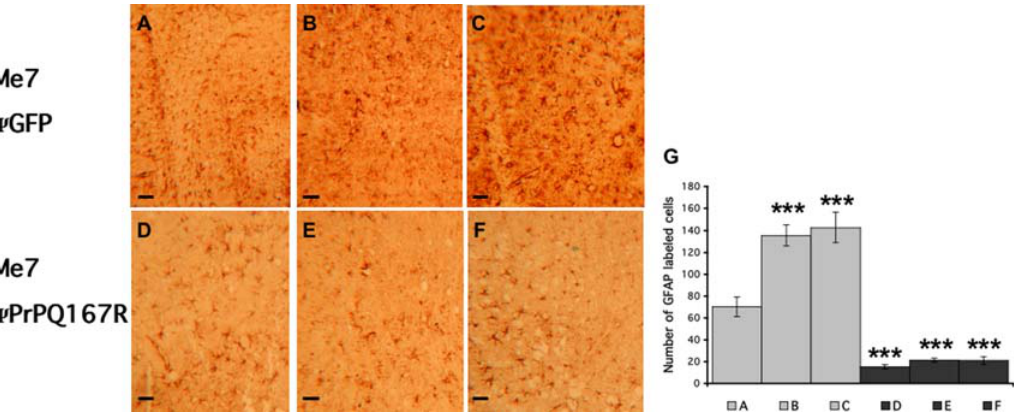
Figure 8. GFAP labelling in tissue sections of prion-infected mice treated with Y GFP or Y PrPQ167R. The plus ( + ) signs indicate that the mice were inoculated with the Me7 prion strain. Mice received two injections of either Y GFP (A, B and C) or Y PrPQ167R (D, E and F). The section presented here are representative of the global labelling in the cortex, both in the cannula side (A and D) or non-cannula side (C and F) and in the thalamus (B and E). Bars, 6 m M. The histogram represents the mean number of GFAP-labelled cells in one mouse per group, which was measured by counting GFAP-positive cells in five squares of 10,000 m m 2 each using Mercator software. The histogram represents the means 6 s.e.m. Statistical analysis was done using STATVIEW 5 software. Values were analyzed by ANOVA followed by the PLSD Fisher test (n=5). Multiple comparison analysis among A, B, C, D, E, and F showed that they were all statistically significant (***, p , 0.0001), except for B versus C, and D versus E versus F.